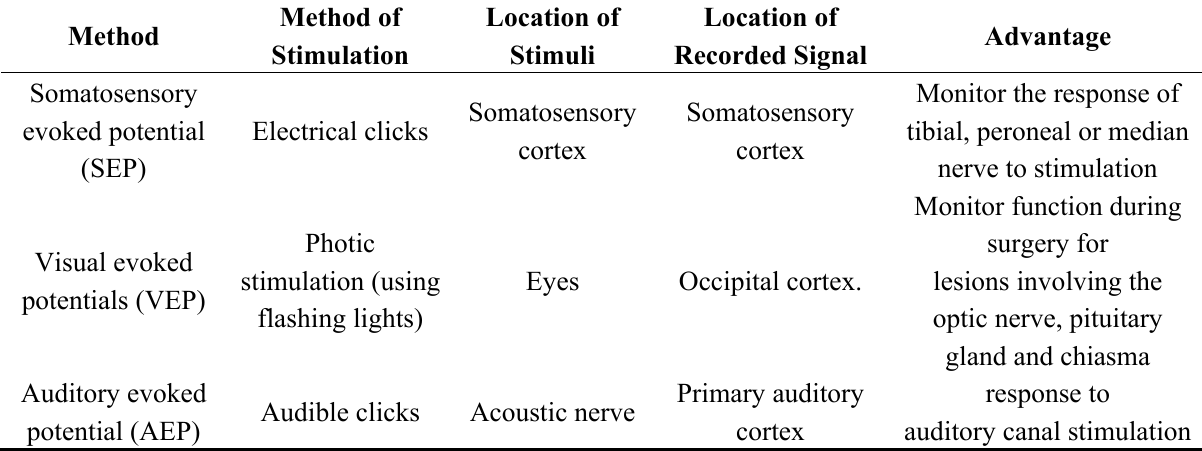
Table 6. Various Evoked potential methods that used to monitor